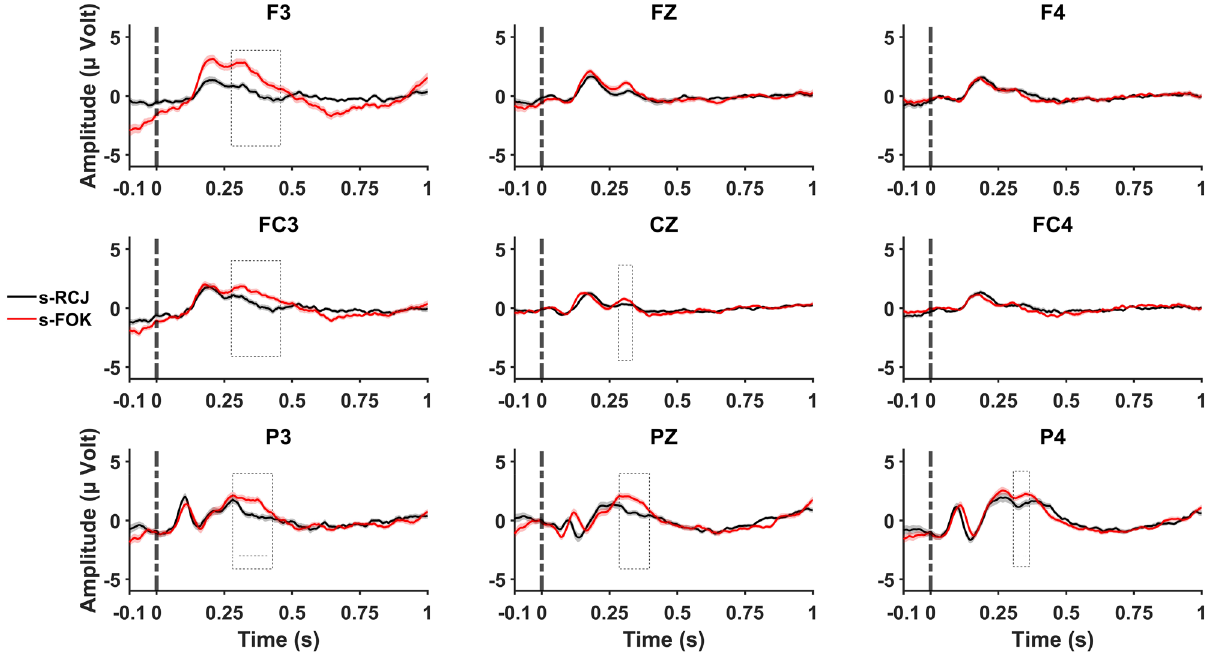
Figure 3. Stimulus-locked ERP grand average with standard errors during the semantic memory task for RCJ (black line) and FOK (red line) at F3, Fz, F4, FC3, Cz, FC4, P3, Pz, and P4 electrode sites Stimulation applied at “0.0 ms” time point (stimulus onset). Cluster-based permutation tests were run within 50–900 ms, and dashed boxes indicate latencies that were found to exhibit significant effects.